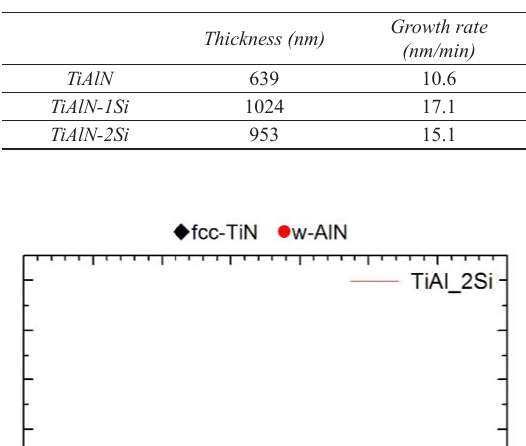
Table 3. Thickness of (AlTiSi) N films with different contents of